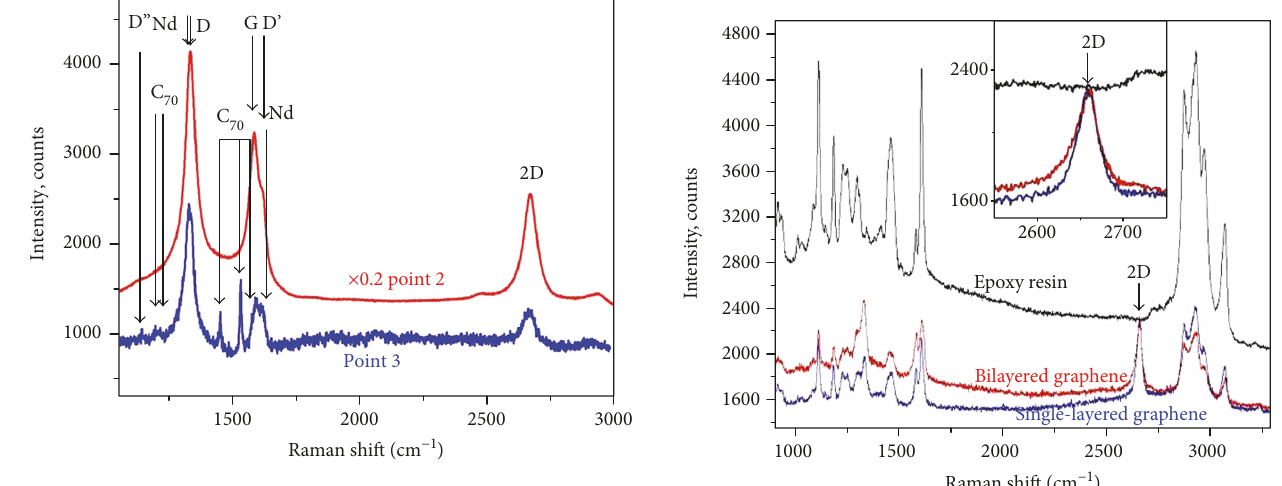
Figure 6: Raman spectra of the interlayer that remains on the substrate after exfoliation by the Scotch tape method taken from points 2 and 3 (Figure 1(c)).